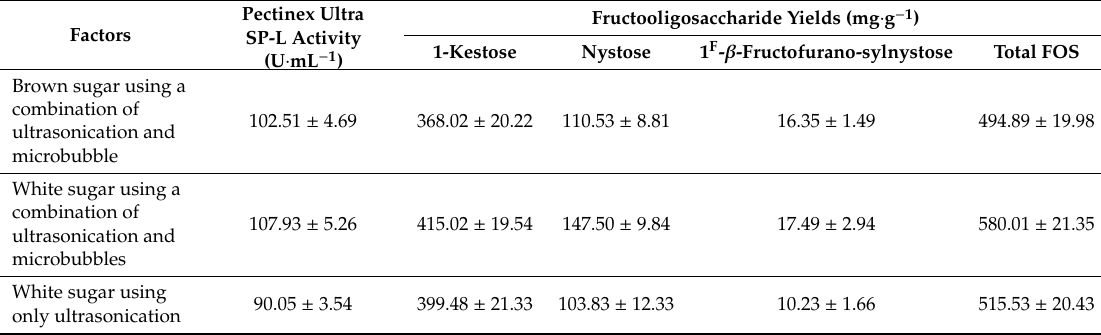
Table 4. Fructooligosaccharide (FOS) yields produced under optimal conditions: ( X 1 )